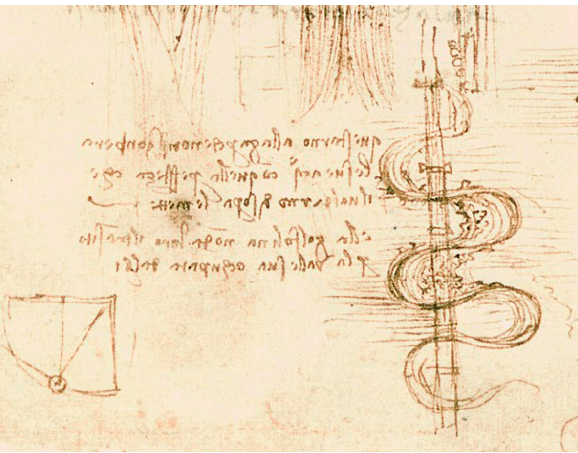
Figure 8. C.A., fol. 785ii r: detail of a study for the Arno